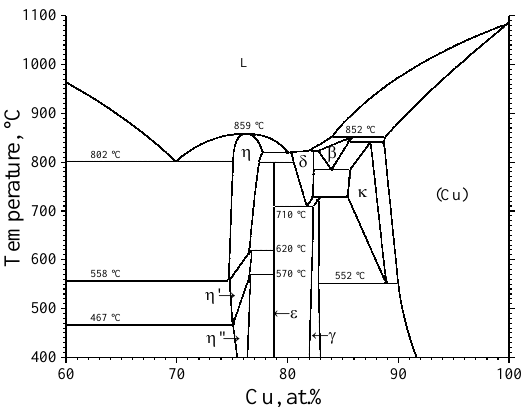
Figure 1. Phase diagram of the Cu-Si system, adopted from [13]. Table 1. Basic information of the copper silicides. Temperature Range, ◦ Phase Composition, at.% Cu [14]